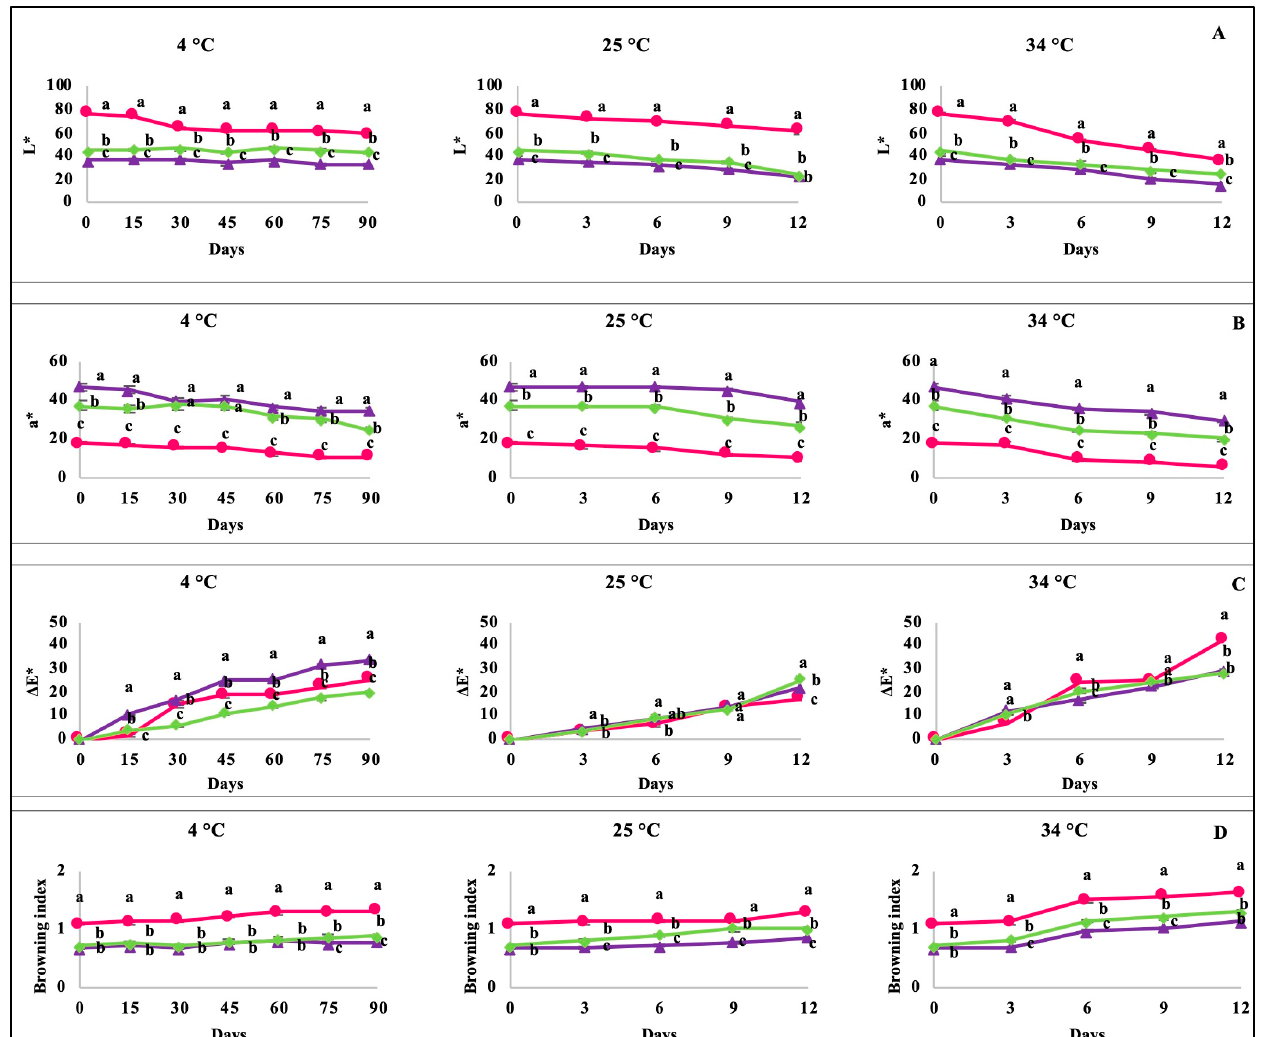
Figure 1. Changes in CIE parameters and the browning index of the berry-based beverages stored at 4 °C for 90 days and 25 °C and 34 °C for 12 days. ( A ) L*: Luminosity; ( B ) a*: redness/greenness; ( C ) Δ E: color difference; ( D ) browning index. Circles ( • ): Strawberry beverage; triangles ( (cid:78) ): blueberry beverages; diamond ( (cid:7) ): strawberry–blueberry beverage. Data are expressed as the mean ± standard deviation of three replicates. Different letters on the same day indicate significant ( p < 0.05) differences between samples by Tukey’s test .